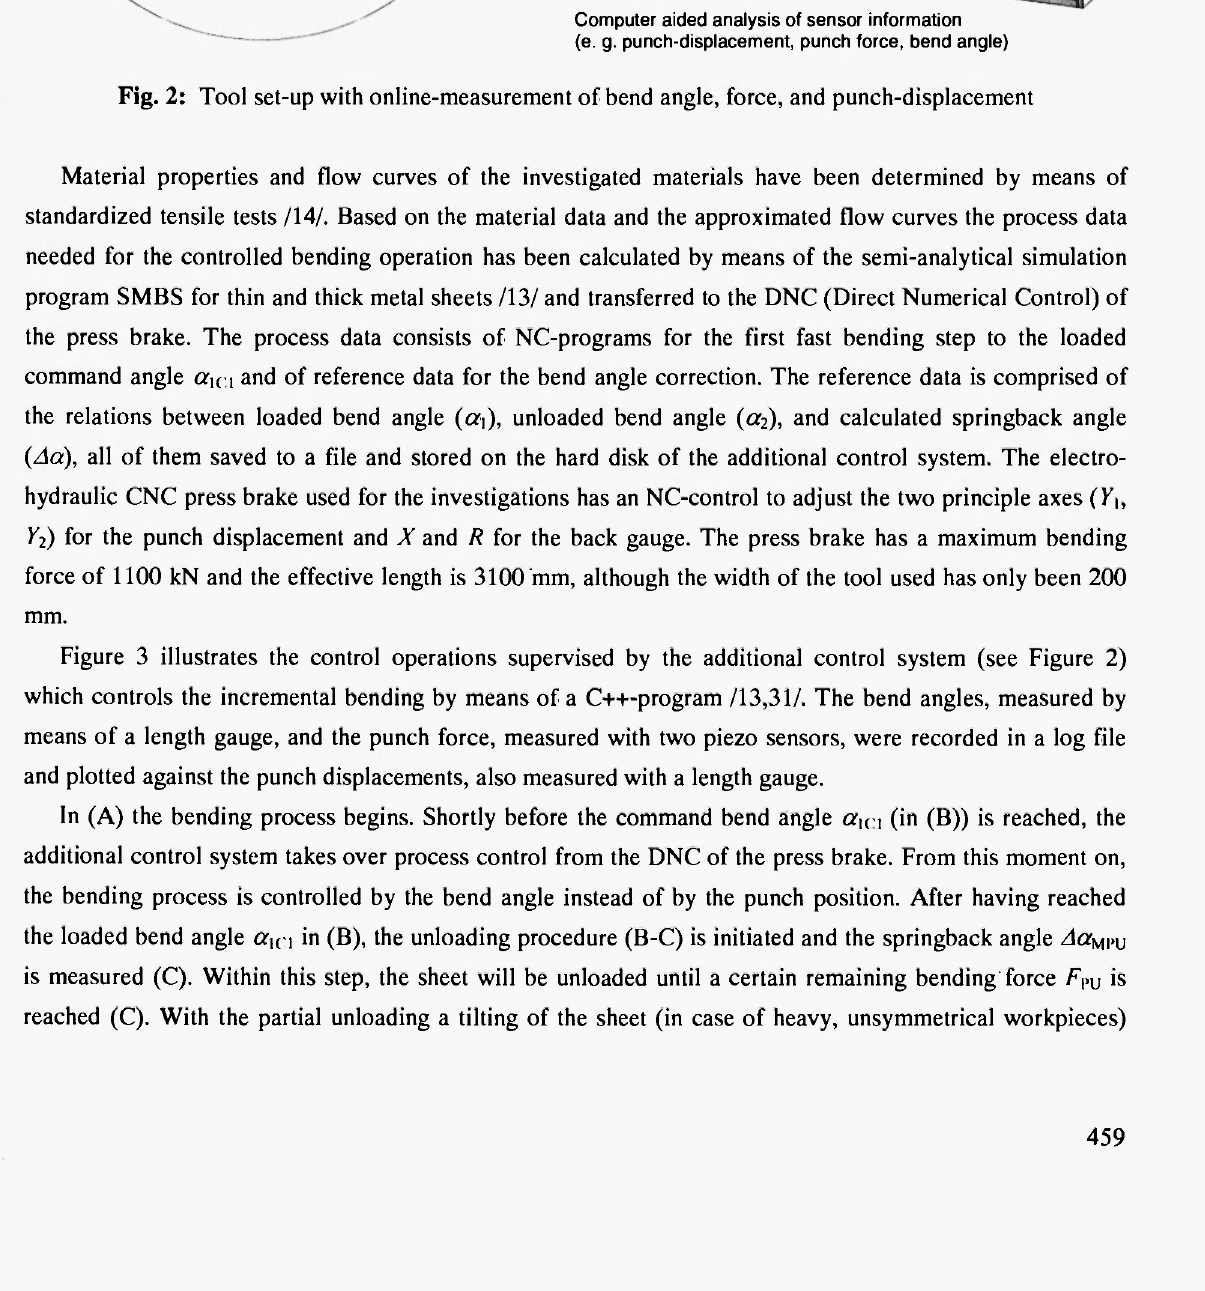
Fig. 2: Tool set-up with online-measurement of bend angle, force, and punch-displacement